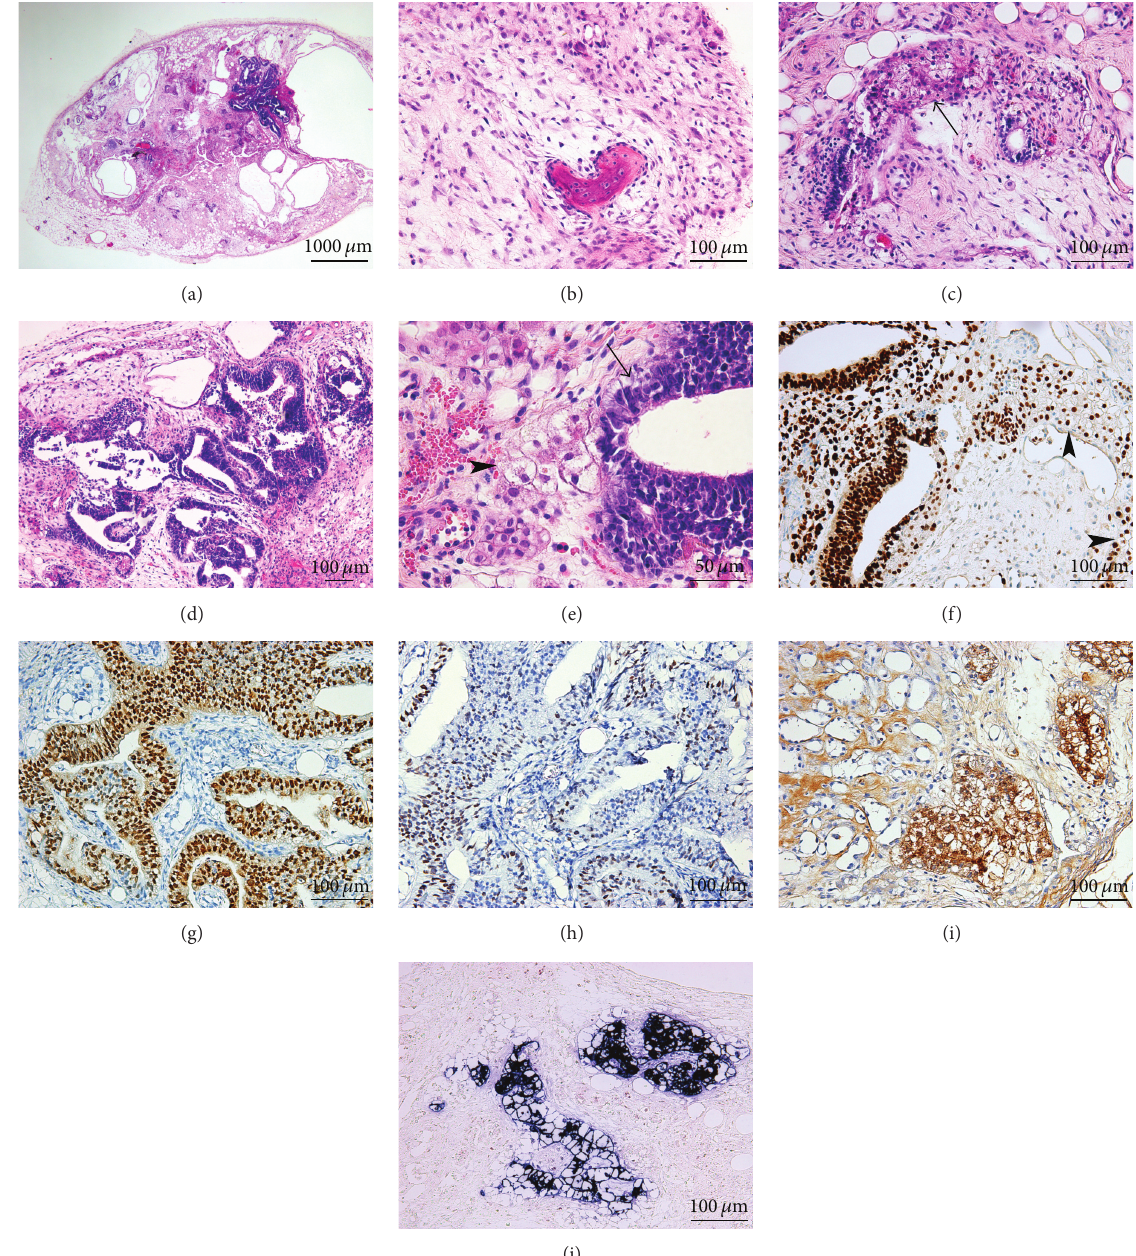
Figure 3: iPSC generated from human hepatocytes, using the OKS integrative vector. The tumors produced were in part cystic (a, H&E 20x) and showed features of immature teratoma. Fibrous bone was part of the mesodermal derivatives and was surrounded by loosely arranged mesenchymal cells (b, H&E 200x). Endoderm-derived structures consisted of variably immature glands focally in close relationship to fetal- like hepatocytes ( arrow ) (c, H&E 200x). Rarely, confluent atypical glandular structures showed stratification (d, H&E 100x); stratified glands ( arrow ) were also focally close to nests of fetal-like hepatocytes ( arrowhead ) (e, H&E 400x). Upon immunohistochemical evaluation, the atypical glands displayed strong expression of SALL4, a feature shared by some of the teratoma components of which the hepatocyte plates are ( arrowheads ) (f, 200x). Strong reactivity to OCT4 was also seen (g, 200x). MYC reactivity was only mild (h, 200x). The fetal-appearing hepatocytes expressed AFP (i, 200x) and albumin (j, in situ hybridization,